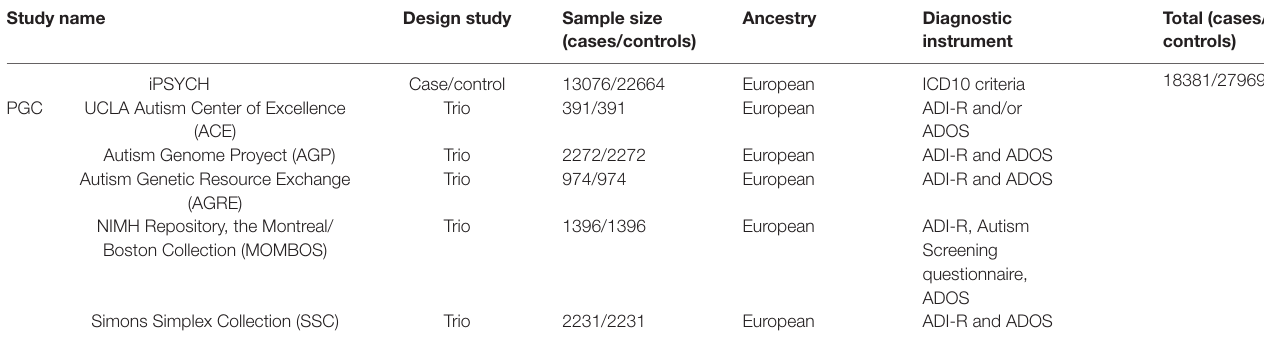
TABLE 1 | Characterization of ASD cohorts included in PGC GWAS meta-analyses.